Question: Which visualization type does this figure use?
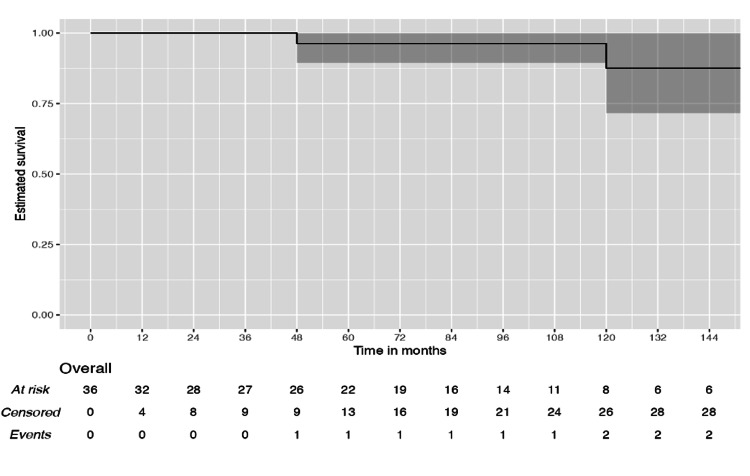
Answer: survival